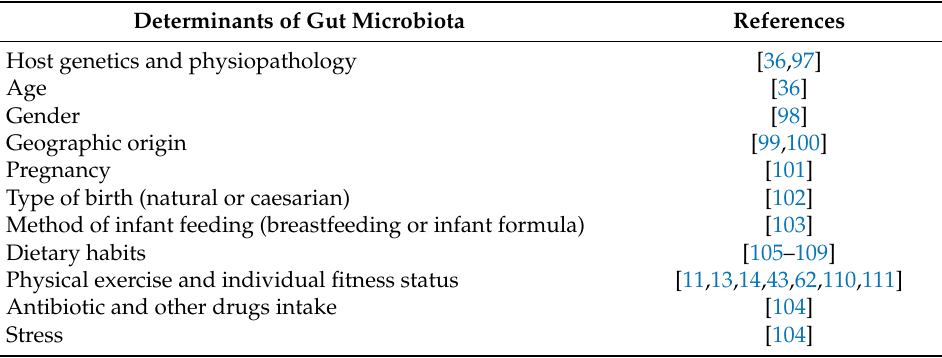
Table 2. Endogenous and exogenous determinants of gut microbiota